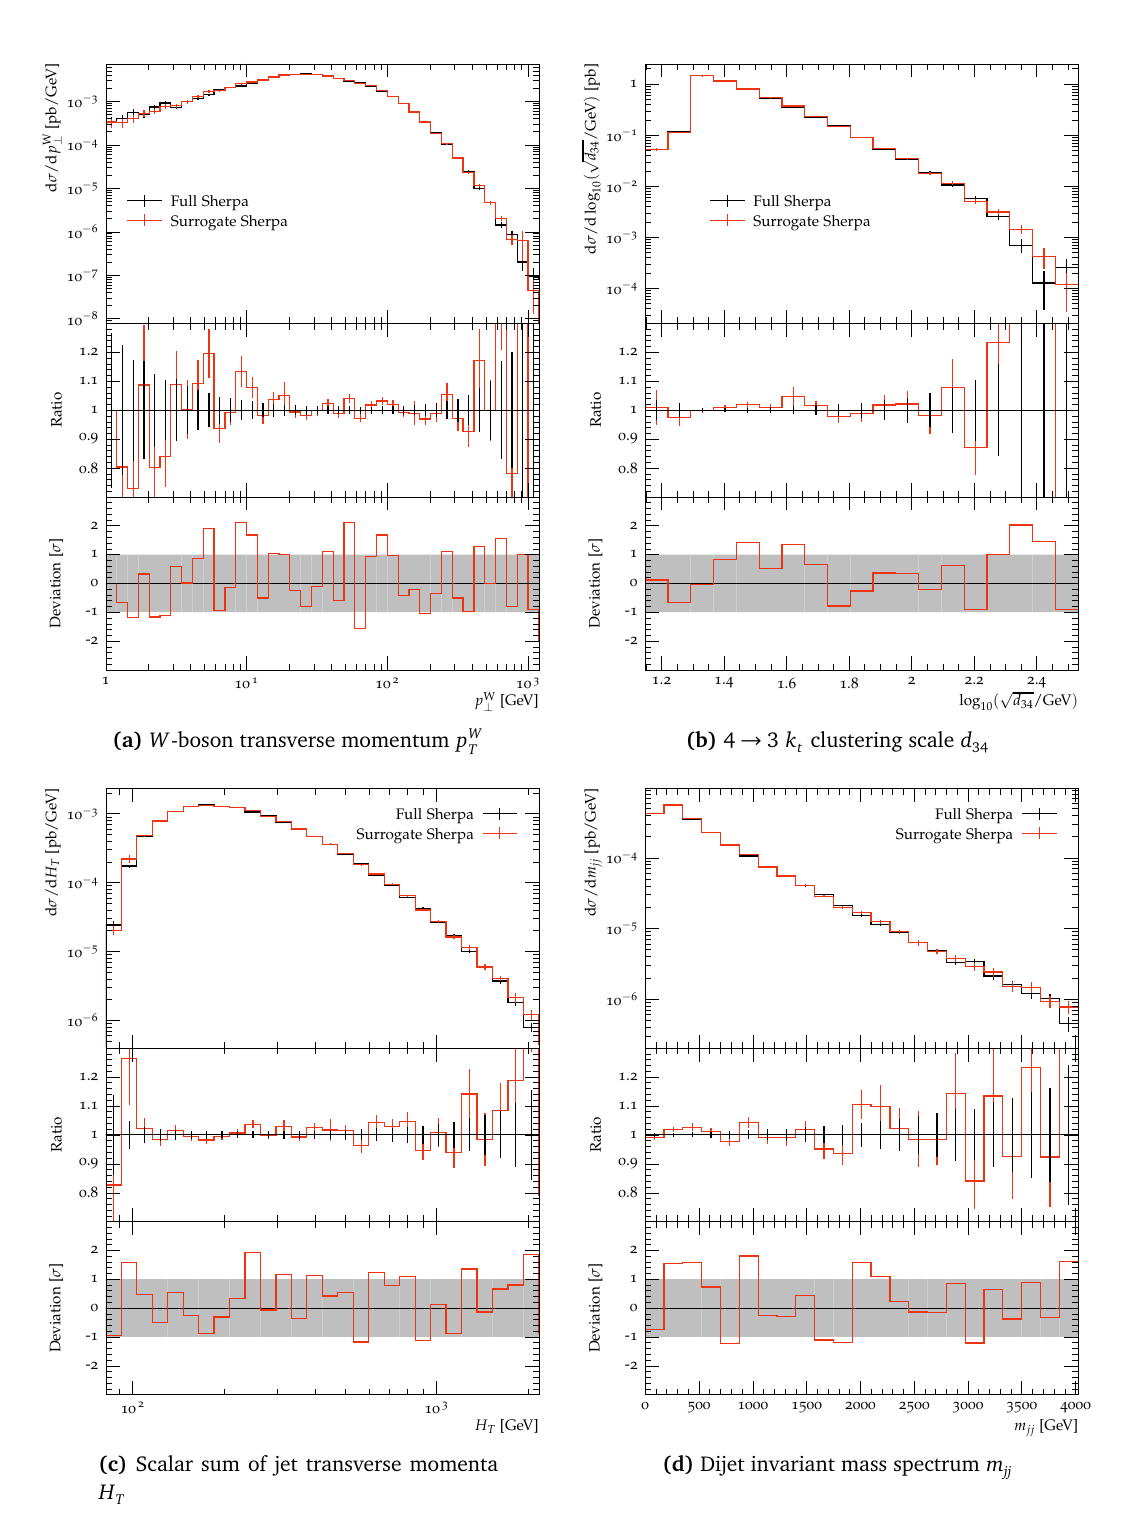
Figure 7: Comparison of different differential distributions generated using S HERPA with (red) and without (black) an NN weight surrogate for the process dd → e − ¯ ν g gdu in proton–proton collisions at e